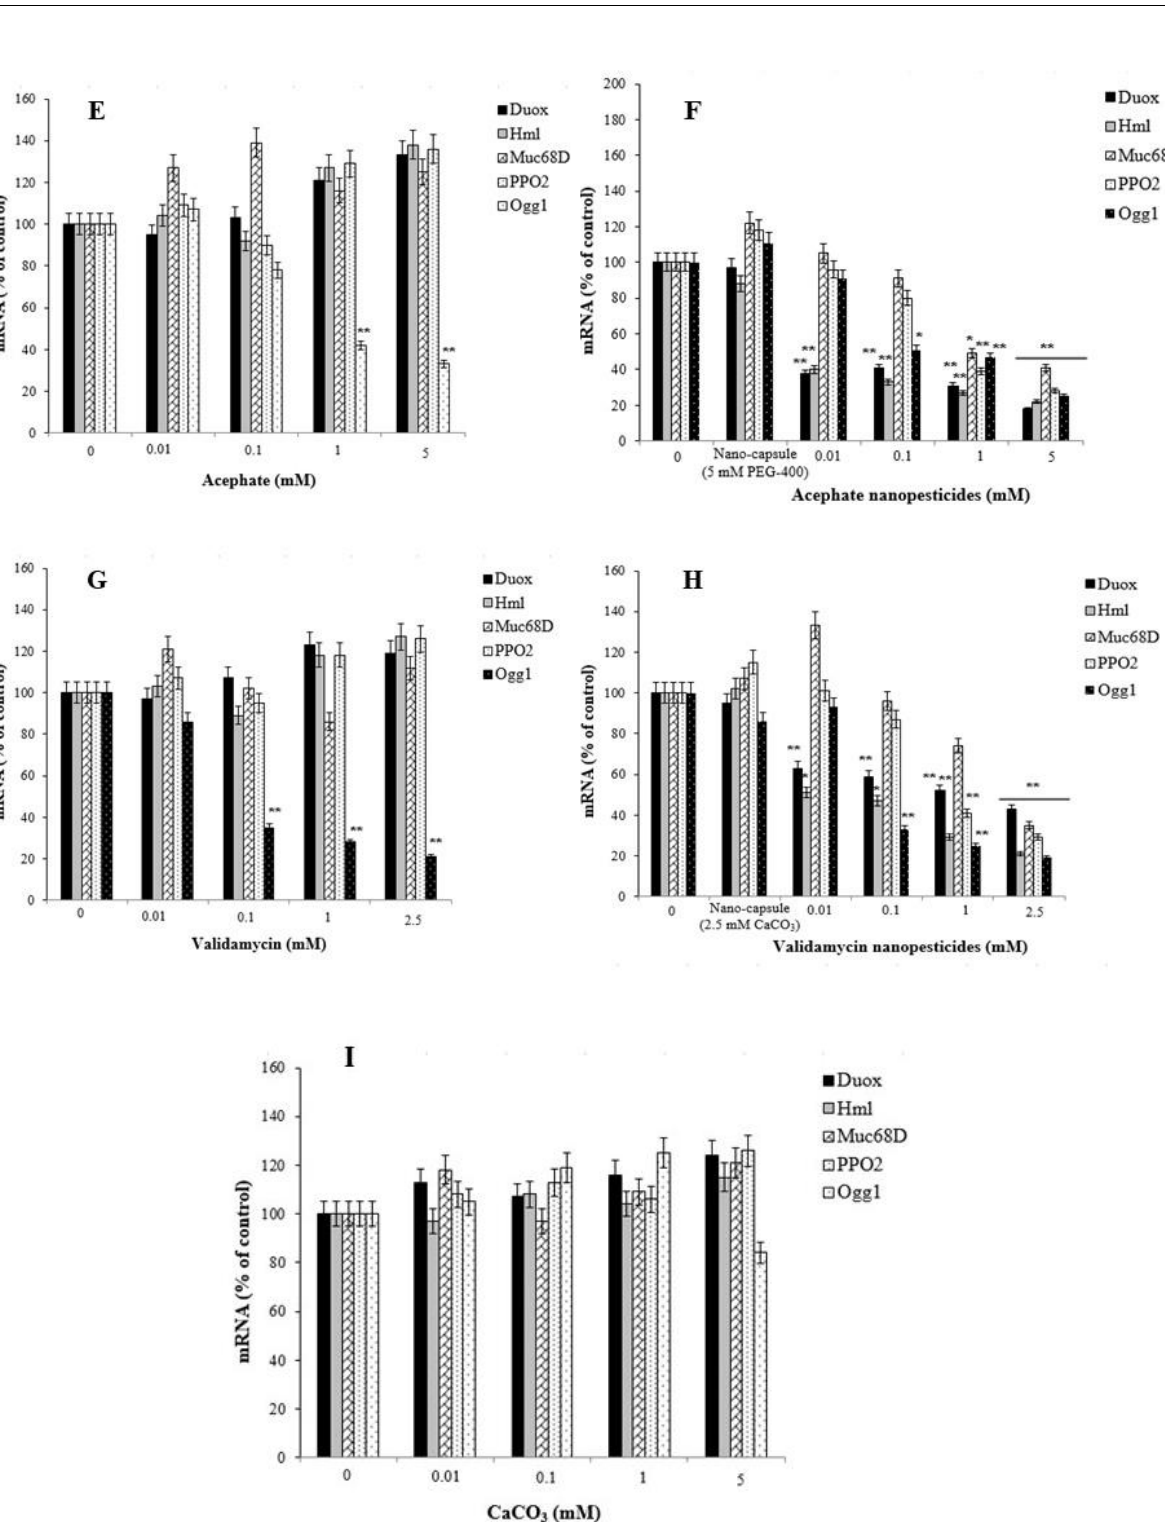
Figure 13. The expression of genes related to midgut injury and hemocyte interactions (Duox, Hml, Muc68D, and PPO2) and DNA repair (Ogg1) in D. melanogaster larvae exposed to permethrin ( A ), permethrin nanopesticides ( B ), CuSO 4 · 5H 2 O ( C ), Cu(OH) 2 nanopesticides ( D ), acephate ( E ), acephate nanopesticides ( F ), validamycin( G ), validamycin nanopesticides ( H ), and CaCO 3 ( I ). The expressions were normalized using β -actin. Data represent the mean ± standard error of the mean of six independent experiments; * p < 0.05, ** p < 0.01 (Student’s t -test). Concentration-dependent decreases were observed in the expression of the Hsp70 , Hsp83 , and SOD2 genes after exposure to CuSO4.5H 2 O (0.01, 0.1, 1, and 5 mM) and Cu(OH) 2 nanopesticides (0.01, 0.1, 1, and 5 mM). However, a significant decrease in Hsp70